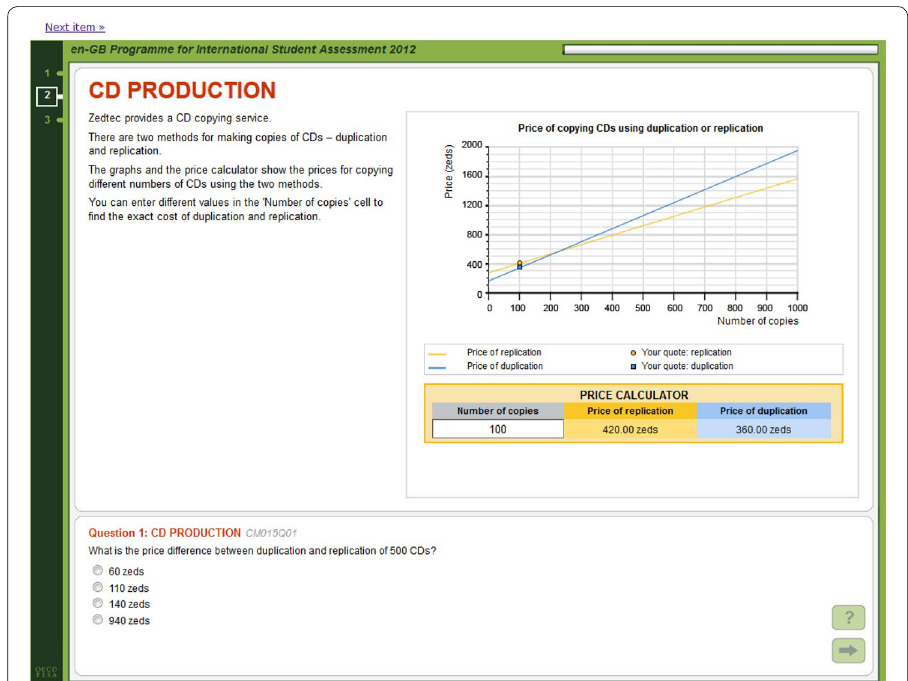
Fig. 5 Example item CD production part